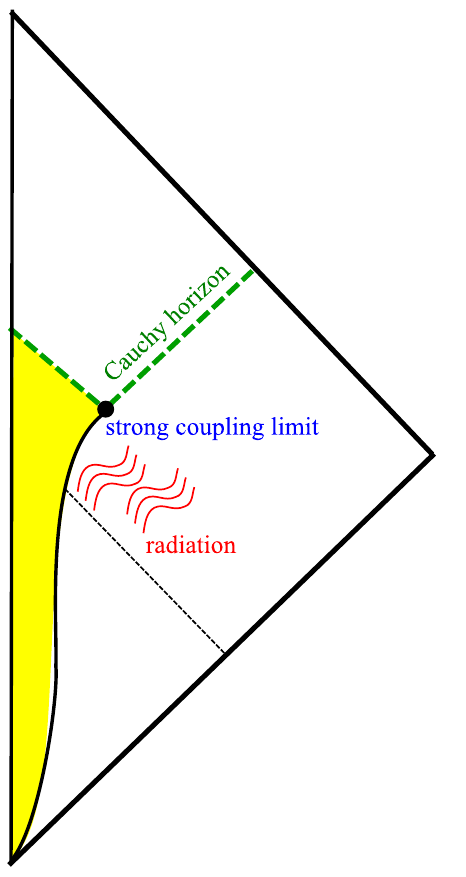
Fig. 10 Causal structure of stringy regular stars. As the black hole emits radiation, a will monotonically decrease and will approach the strong coupling limit. After that point, the black hole will quickly dis- appear due to the strong radiation